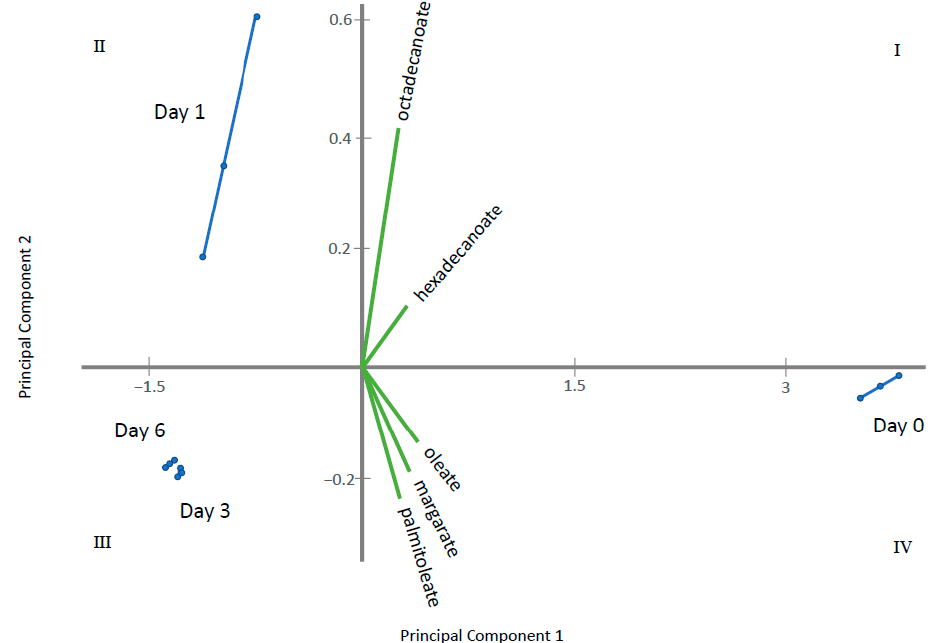
Figure 6. Principal Component Analysis (PCA) for fatty acids where Principal Component 1 displays 98.4% of the variability and Principal Component 1 for 1.4%. The green vectors represent each metabolite, whose projection of the vertex on each axis represents its contribution to each PC. The blue points are each sampling time replicate, connected by lines to represent the PC scores of the samples analyzed.